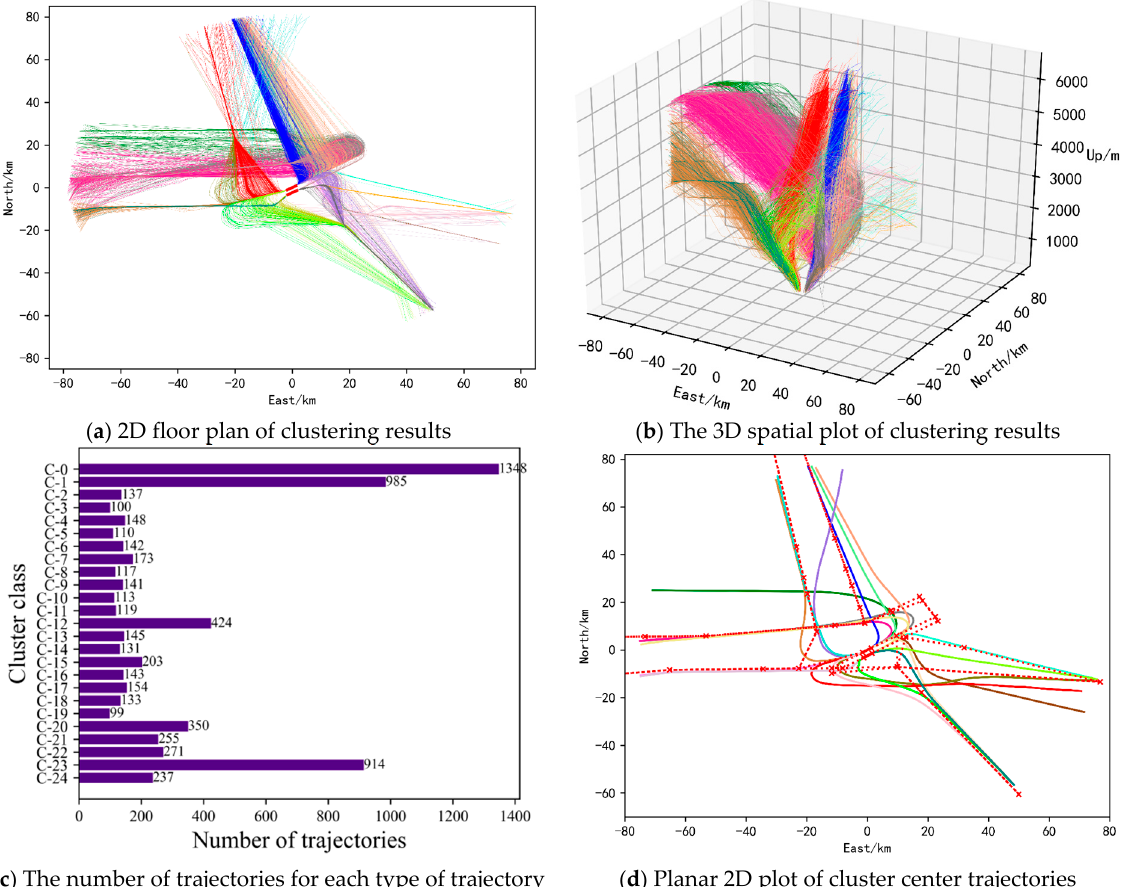
Figure 9. Clustering results of takeoff trajectories.